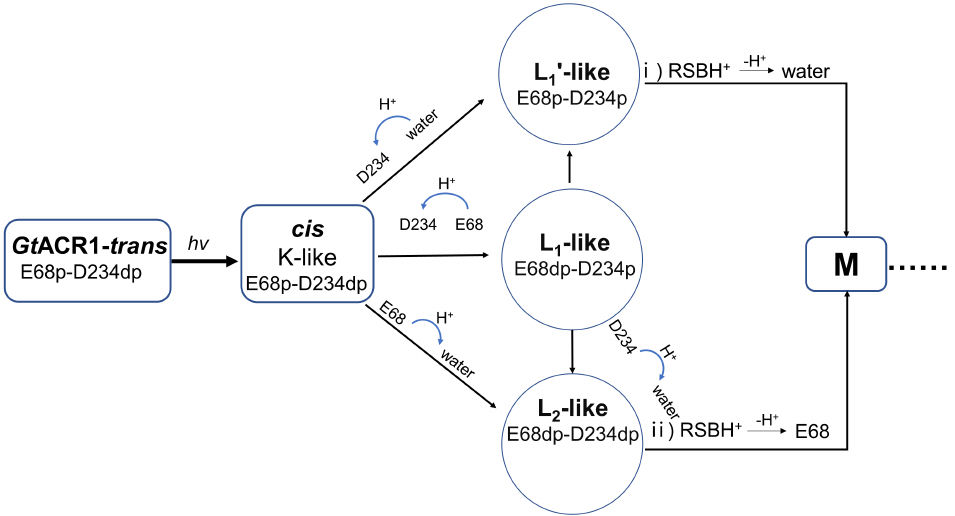
Figure 8. Revised channel opening model of